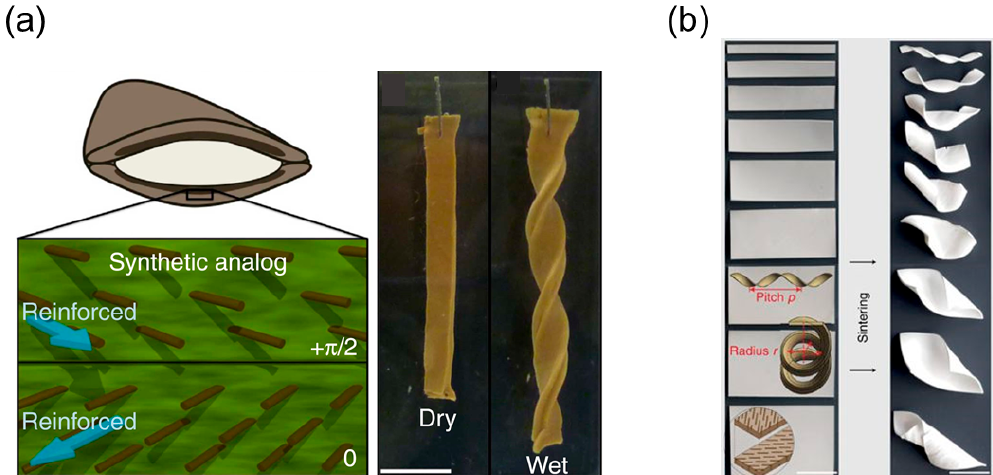
Figure 3. Humidity-responsive hydrogel-based helical structures mimicking Bauhinia variegata , the reinforcement’s distribution is controlled via magnetic field. ( a ) Microplatelet alignment in a bilayer sheet (left, schematic) mimicking Bauhinia variegata and shape transformation of the synthesized hydrogel in water (right). The scale bar is 1 cm. ( b ) Microplatelet-induced shape transformation of ceramics from a planer sheet (left) to a helical shape (right) after sintering, the radius and pitch of the helix are influenced by the ribbon’s width from top to bottom (right). The scale bar is 25 mm; ( a ) is from [27], reproduced with permission; ( b ) is from [65], reproduced with permission, copyright 2013 Nature Publishing Group.